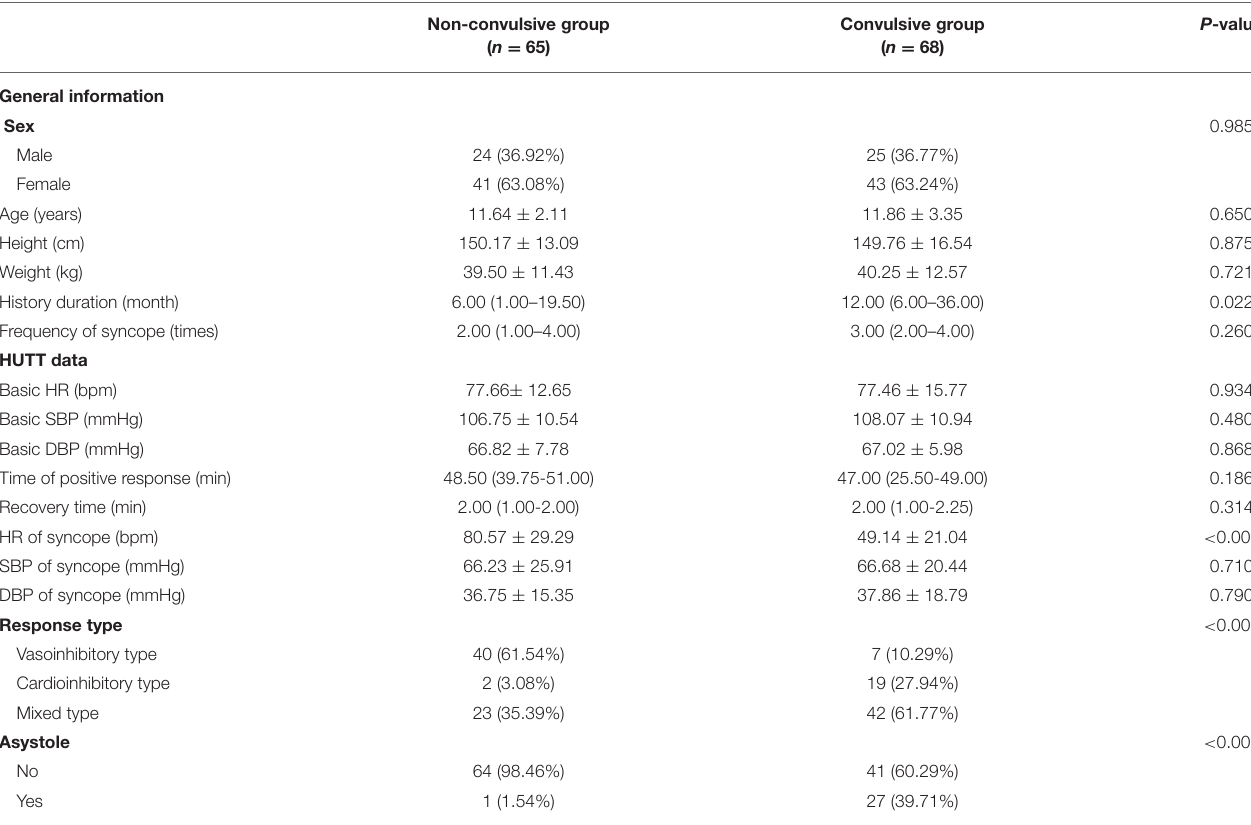
TABLE 1 | The clinical characteristics of VVS patients with or without seizure-like activities [Mean ± SD, M (Q1–Q3), n (%)].